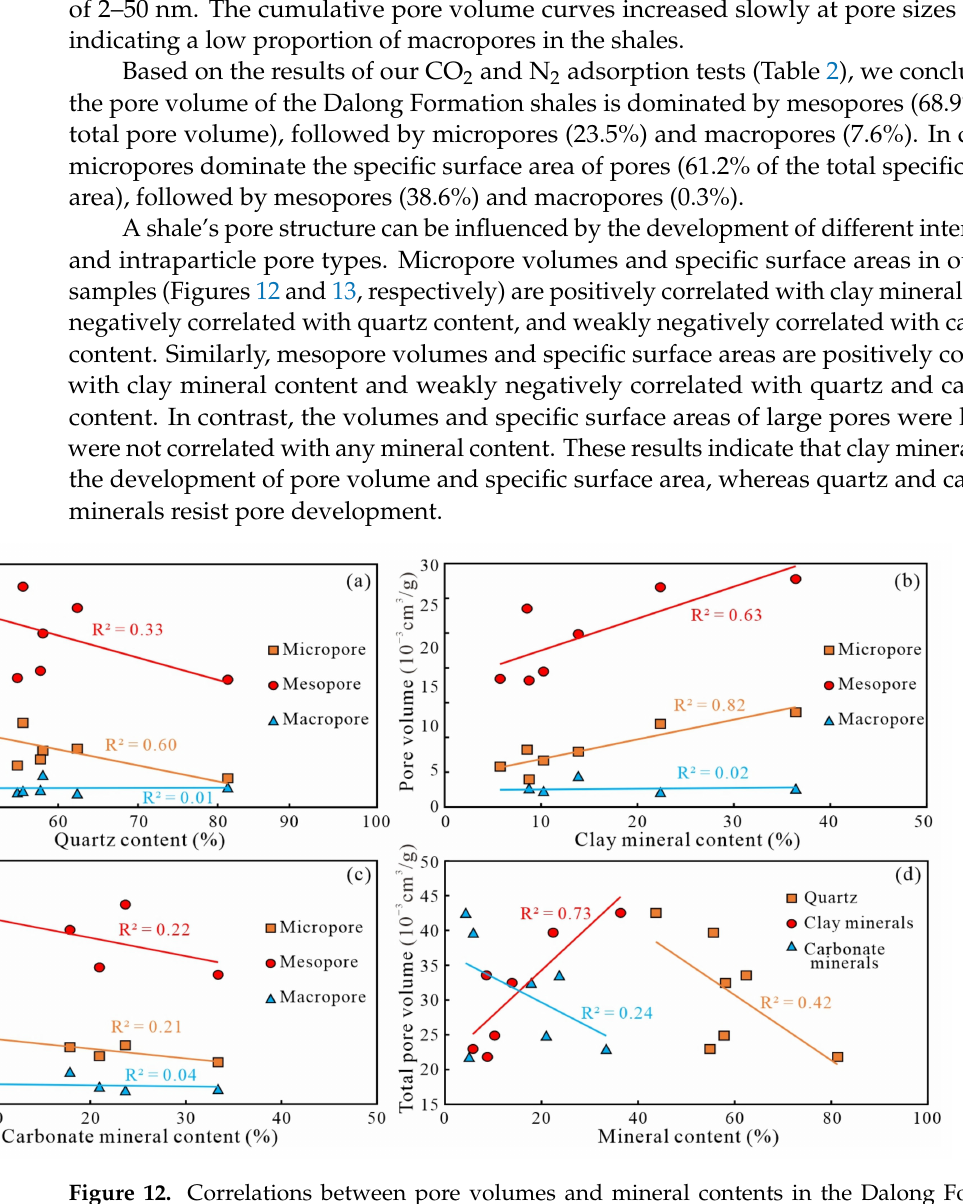
Figure 12. Correlations between pore volumes and mineral contents in the Dalong Formation. Correlations are shown between pore volume, separated by pore size class, and ( a ) quartz, ( b ) clay mineral, ( c ) carbonate mineral contents, as well as ( d ) between total pore volume and individual mineral